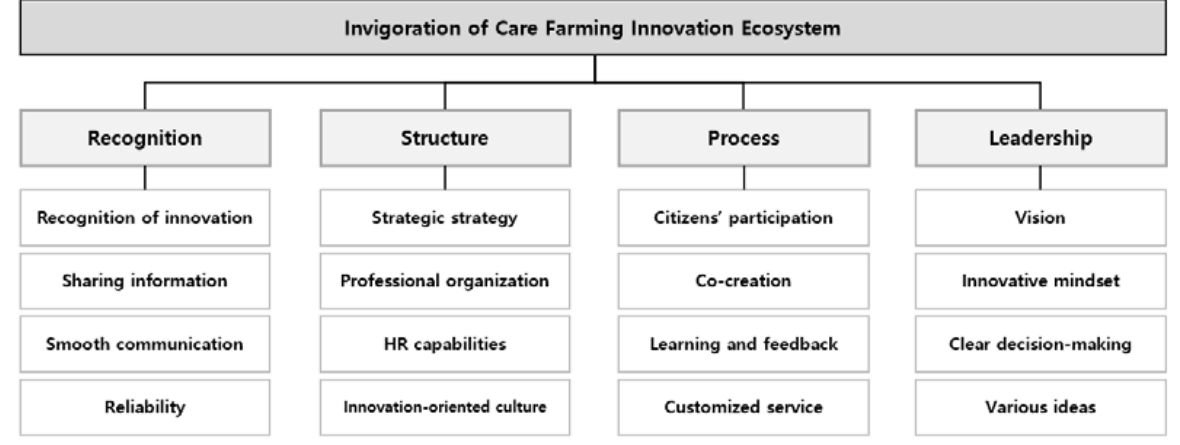
Figure 3. Research concept framework. Table 4. Evaluation factors and definition.